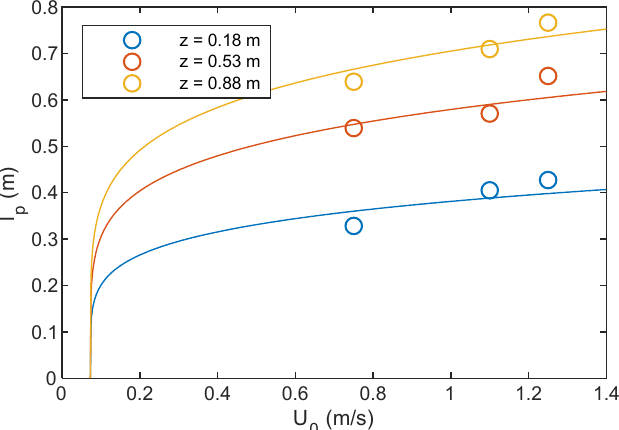
Figure 9. Cross-sectional averaged mean pierced lengths measured at different heights above the gas distributor compared with the correlation prediction as function of superficial gas velocity in the FB1000 unit.